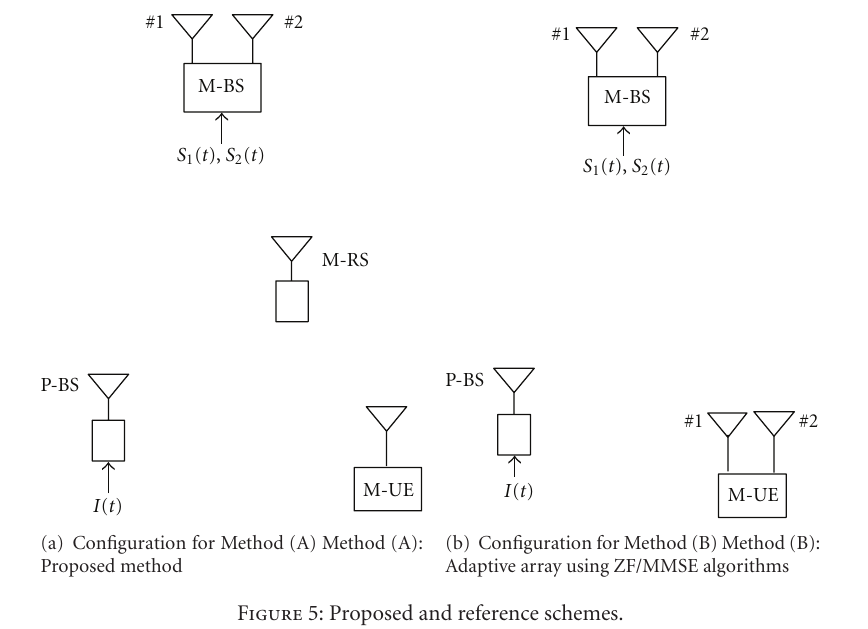
Figure 5: Proposed and reference schemes.